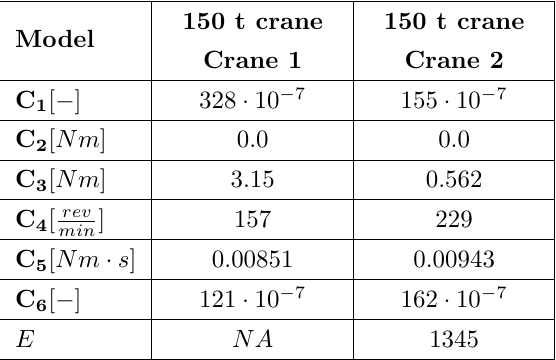
Table 3: Optimized system friction parameters